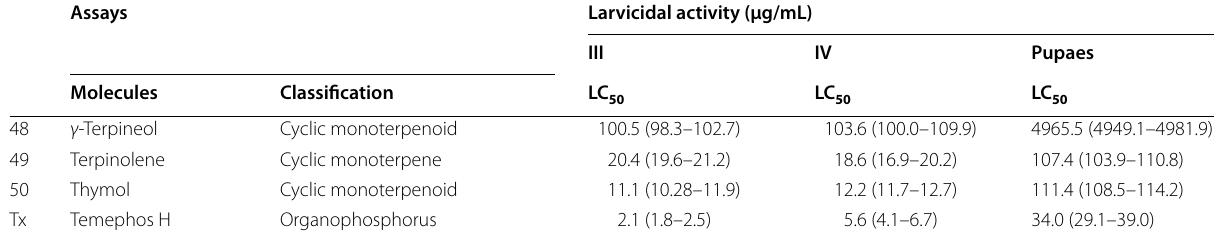
Table 2 Summary of the statistics quantitative structure–larvicidal activity relationship models for activity against fourth instar of Cx. quinquefasciatus